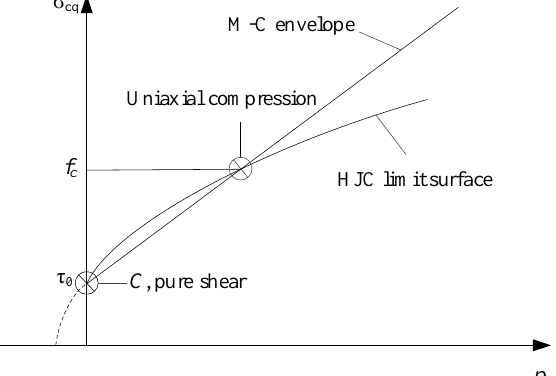
Figure 13. Relationship between the HJC limit surface and the M-C envelope.